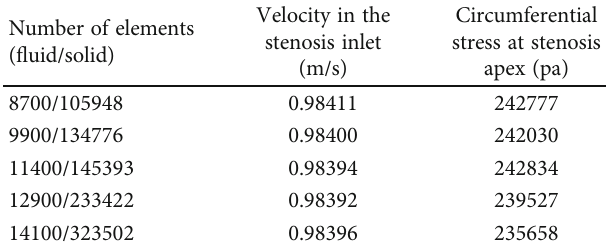
Table 1: Mesh independence study results for 70% stenosis from